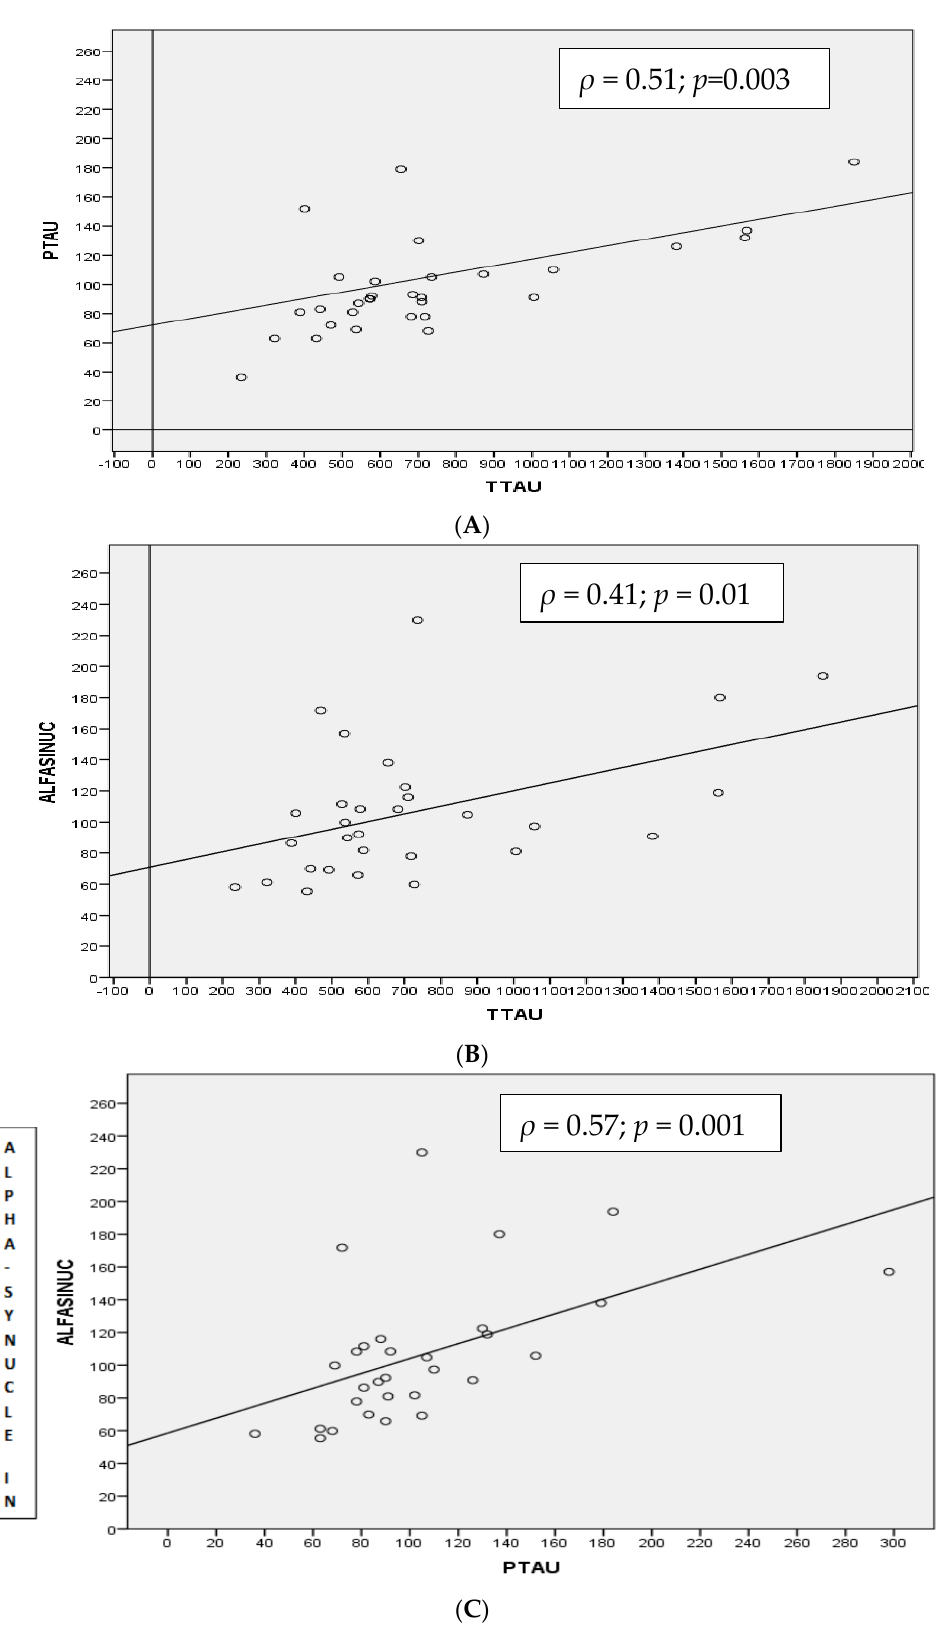
Figure 2. Spearman correlation ( ρ ) between CSF T-tau and p-tau 181p ( A ), α-synuclein and T-tau ( B ) and α-synuclein and p-tau 181p ( C ) proteins in MCI-AD group.